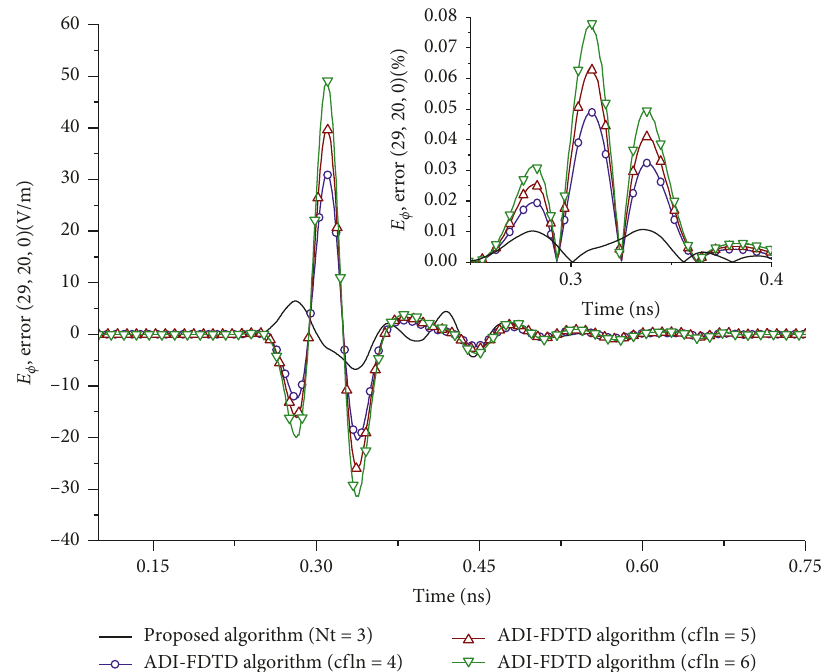
Figure 16: Errors obtained by E